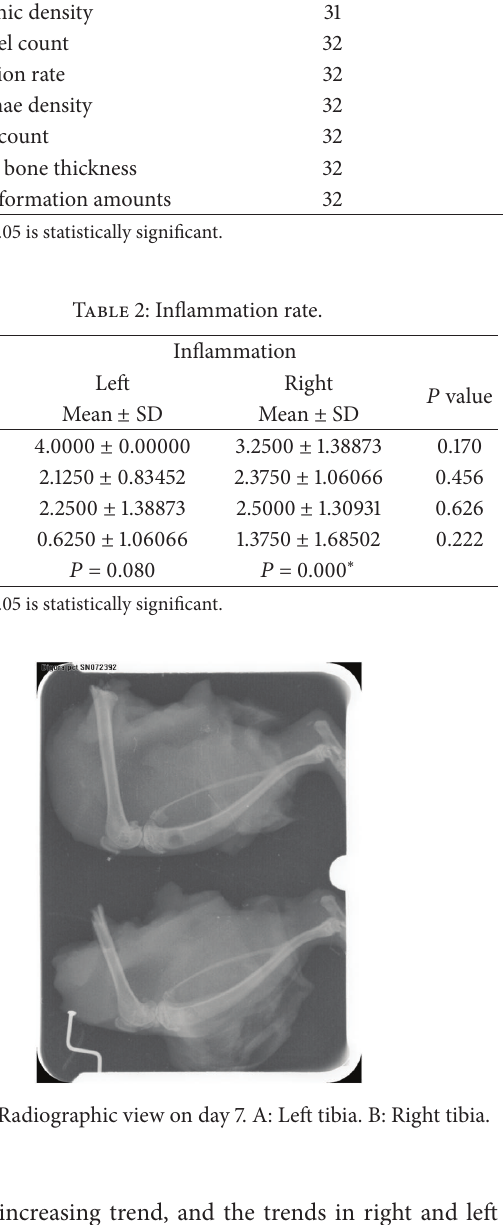
it had an increasing trend, and the trends in right and left tibias are statistically significant ( 𝑃 values = 0.001, 0.013).